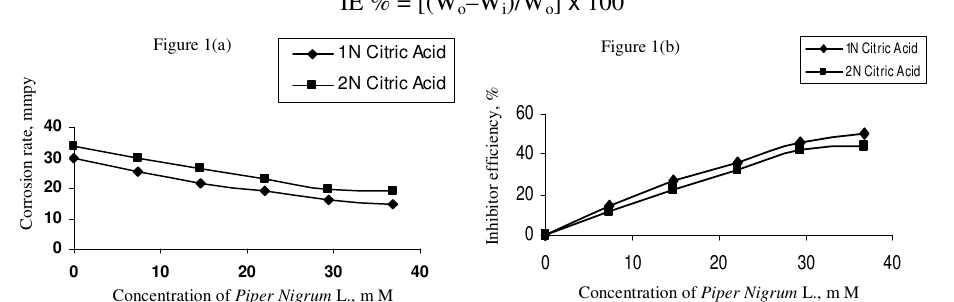
Figure 1 (a). Comparison of corrosion rate (CR) with concentration of Piper Nigrum L. (b) Comparison of inhibition efficiency (IE) with concentration of Piper Nigrum L. (in %) in